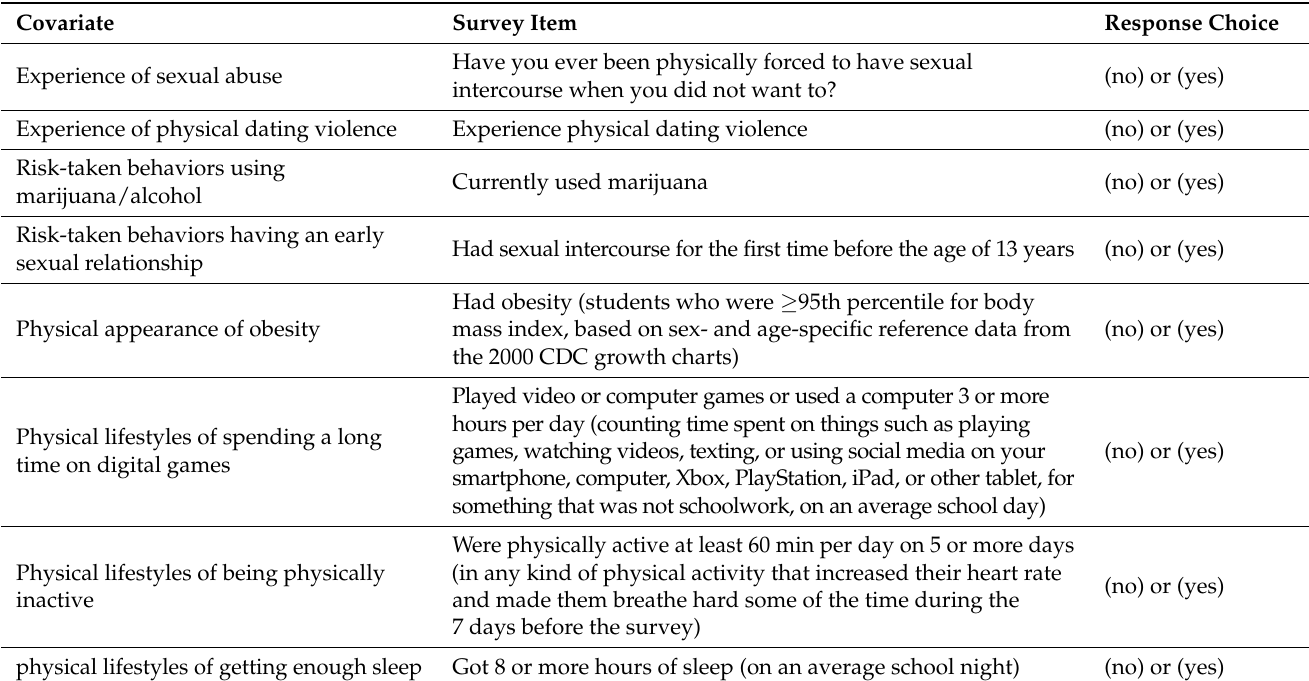
Table 1. Detailed description of covariates based on the 2019 Youth Risk Behavior Surveillance System (YRBSS) national